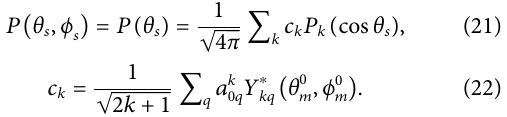
Frontiers in Chemistry |